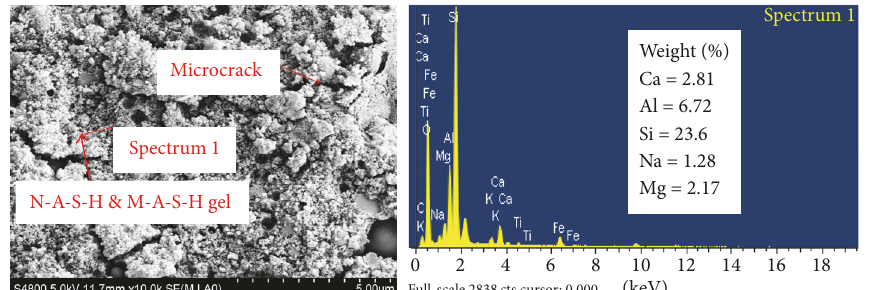
Figure 16: SEM and EDS results of FAGC in the 32-cycle MgSO 4 attack environment.